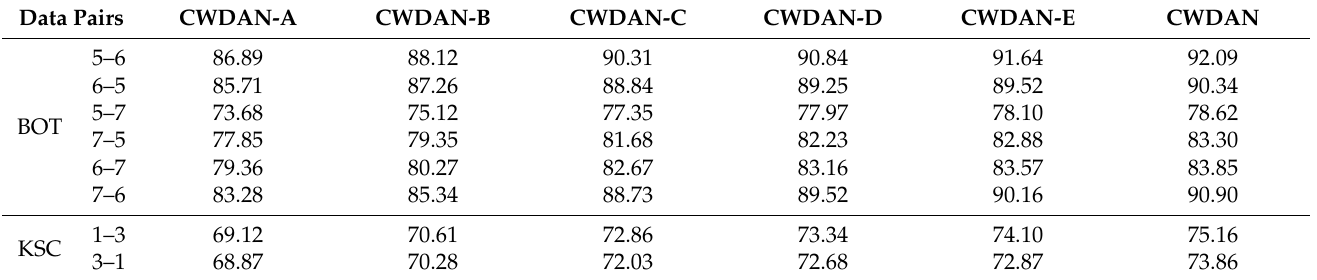
Table 7. Impact of different techniques on OA